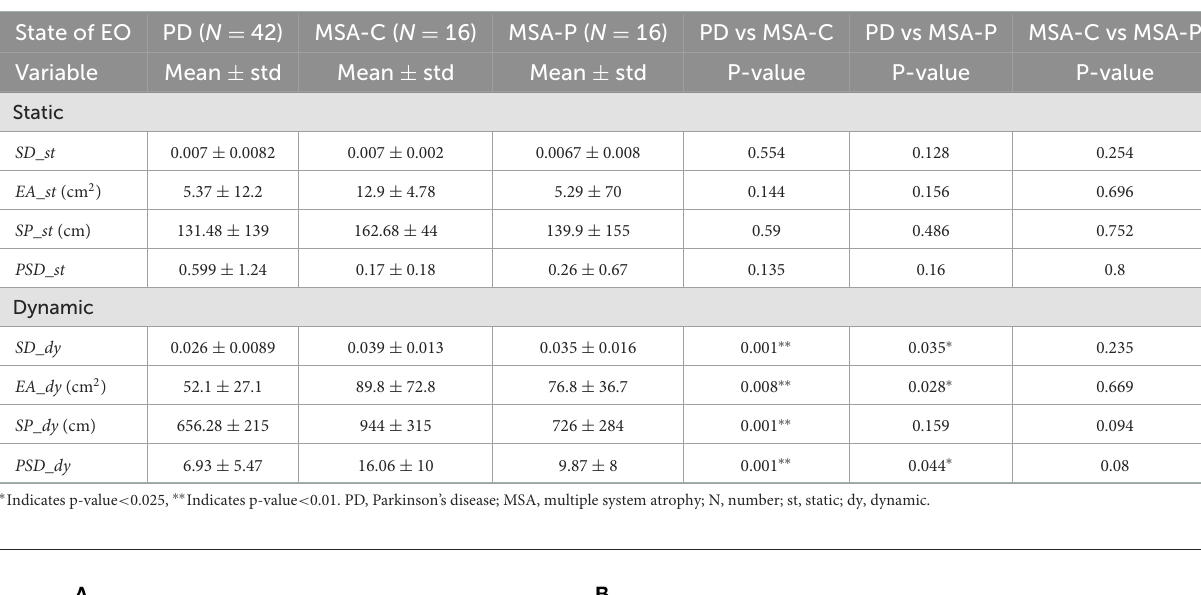
TABLE 4 Statistical results of posturographic variables MSA-C, MSA-P, and PD groups.